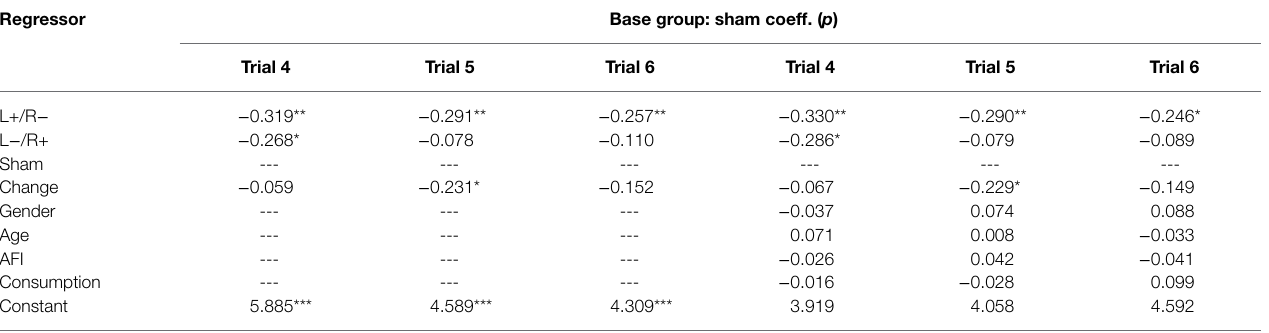
TABLE 4 | The coefficients and significances of the regression models (trials 4–6). Regressor